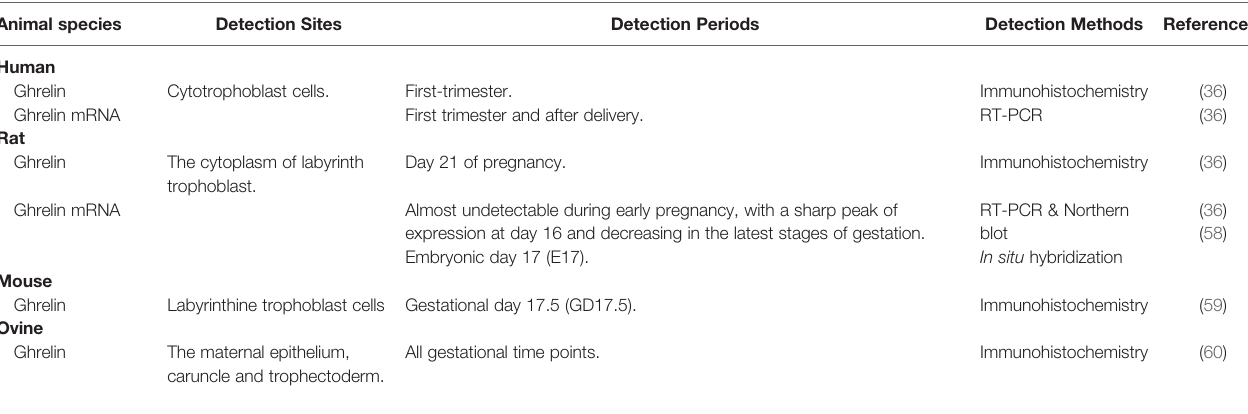
TABLE 1 | Detection of ghrelin in the placenta. Animal species Detection Sites Detection